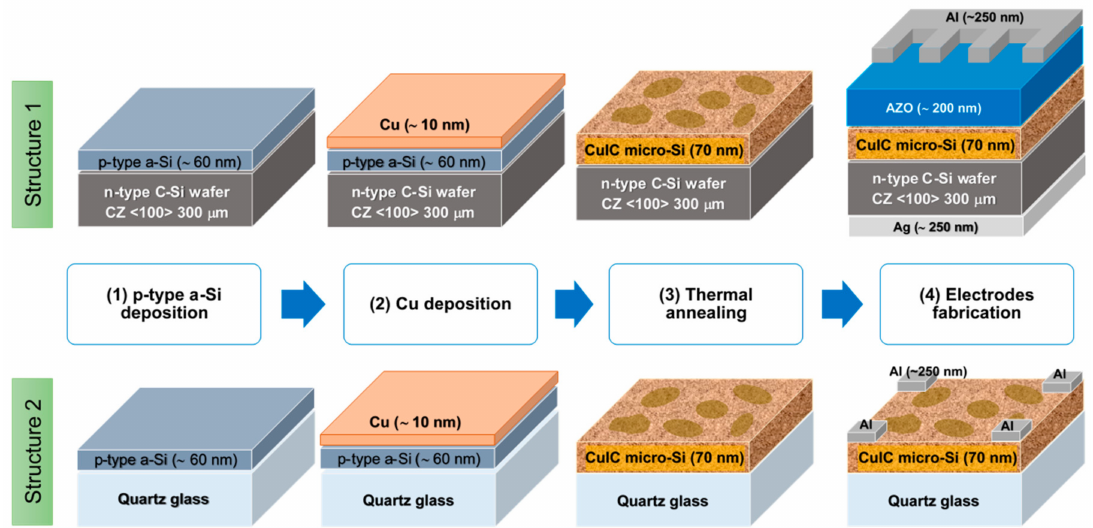
Figure 1. Step by step process of CuIC micro-Si thin film fabrication in this research: (top row) deposited p-Si / Cu / AZO tandem layers on n-type C-Si wafer, and (bottom row) deposited p-Si / Cu tandem layers on quartz